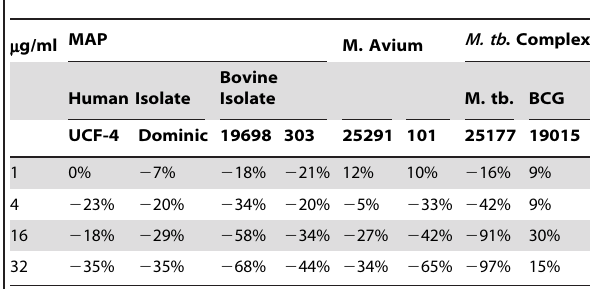
Table 10. 13 Cis-Retinoic